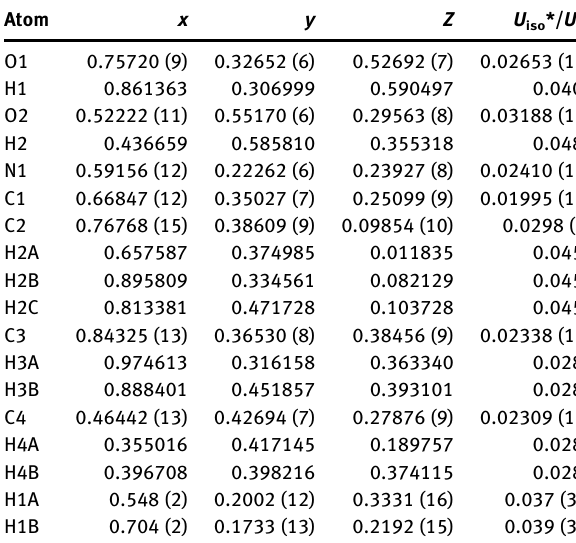
Table  : Fractional atomic coordinates and isotropic or equivalent isotropic displacement parameters (Å 